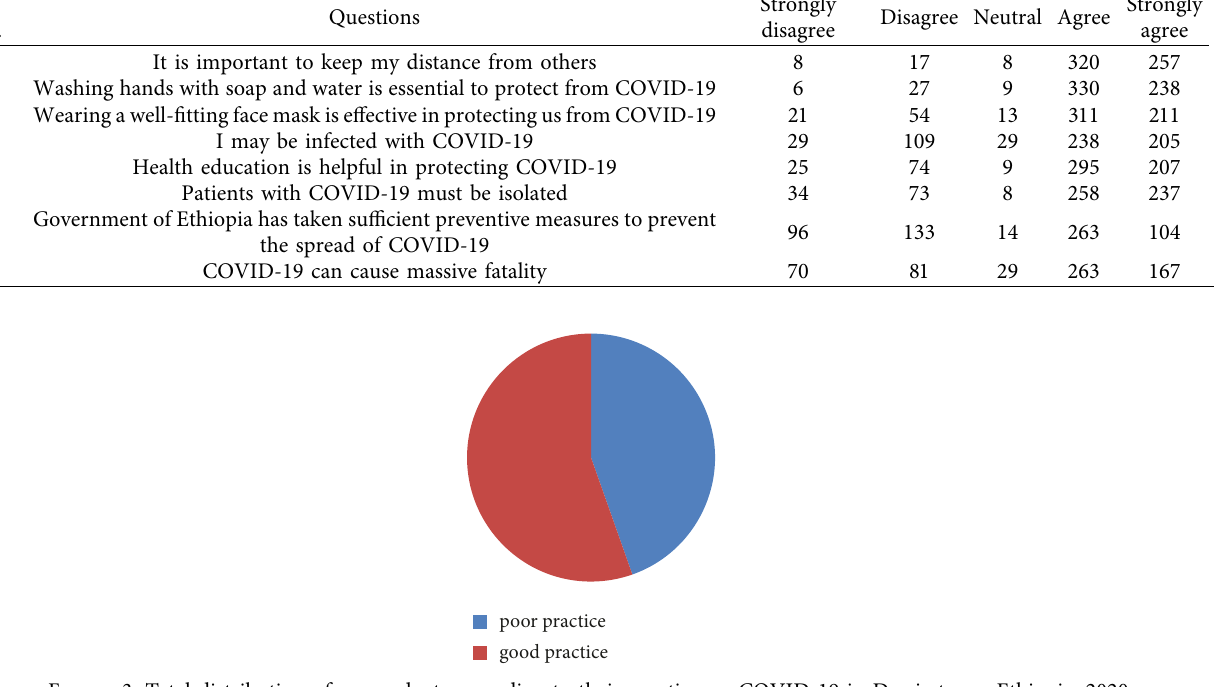
Table 4: Eight questions to evaluate the attitude of mothers towards COVID-19 in Dessie town, Ethiopia, 2020. S.